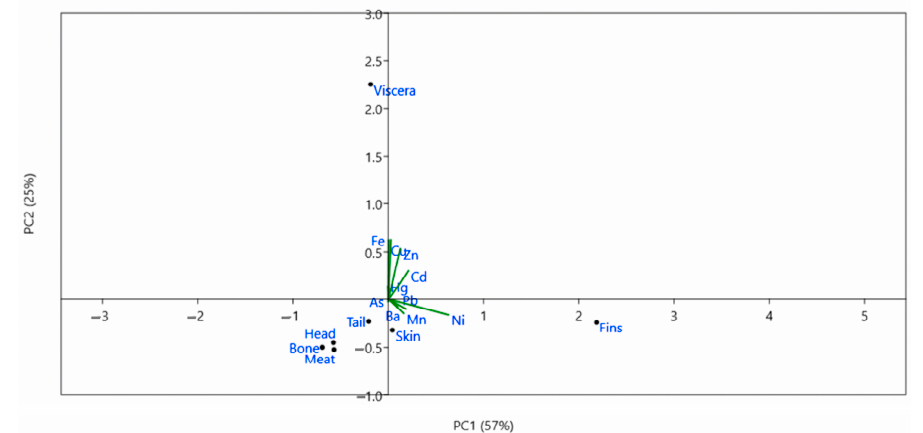
Figure 8. PCA biplot of HMs in various parts of Tilapia spp.